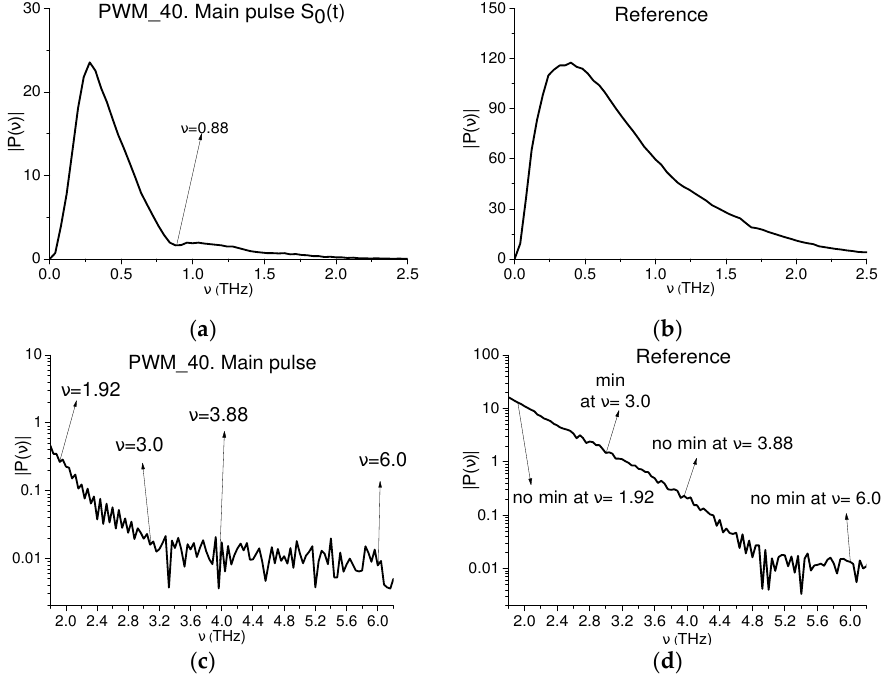
Figure 10. Fourier spectrum of the PWM_40 main pulse ( a , c ) and reference spectrum ( b , d ) in the frequency ranges ν = [0.0, 2.5] THz ( a , b ) and [1.8, 6.2] THz ( c , d ). The spectral amplitudes | P ( ν ) | in ( c , d ) are shown in the logarithmic scale, and the spectral resolution in ( a – d ) is equal to Δ ν = 0.04 THz. Essentially, in Figure 10b, the spectral minima corresponding to the water vapor absorption frequencies belonging to the frequency range ν = [0.1, 2.0] THz [22,23] are absent, which confirms the absence of water vapor during the